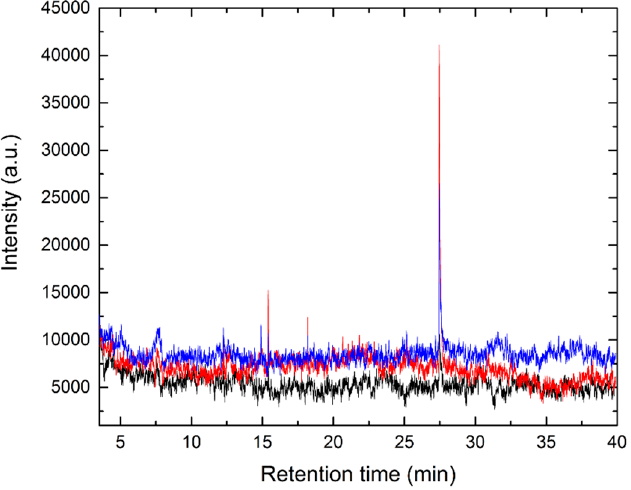
Figure 4. Gas chromatography – mass spectrometry (GC-MS) overlay of snow samples, where the black line represents Newport snow, the red line represents Providence snow, and the blue line represents Kingston snow.